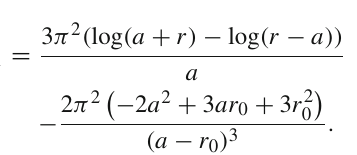
Fig. 4 The variation of DEC against r for parallel plates with r 0 = 1 So by observing the geometry, we have taken r as b (outer radius).